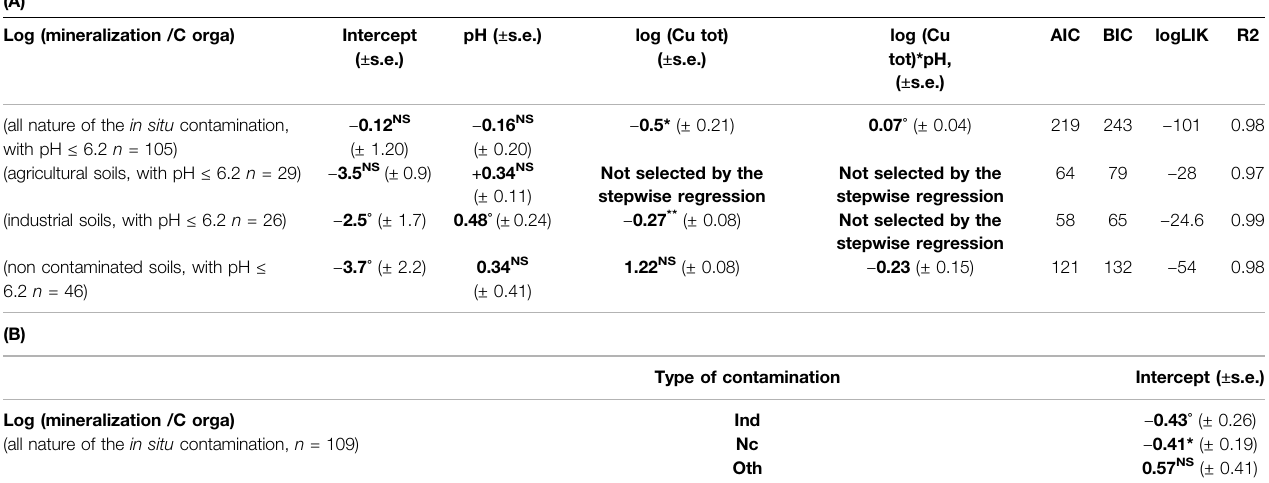
TABLE 4 | (A) Slope and intercept ( ± SE) between log(mineralization/organic C ) and variables selected through step wise analyze for the linear mixed model for different dataset(allnatureofthe insitu contaminationwithpH ≤ 6.2,agriculturalsoilswithpH ≤ 6.2,industrialsoilswithpH ≤ 6.2,non-contaminatedsoilswithpH ≤ 6.2). (B) Shift of the intercept for log(mineralization/organic C) between the different groups of qualitative variable (different types of in situ contamination with pH ≤ 6.2, industrial soils with pH ≤ 6.2,non-contaminatedsoilswithpH ≤ 6.2)andthereferenceone(agriculturalsoils)onlycalculatedforthefulldataset.Boldvaluesareestimatedcoef fi cientthroughstep wise regression.